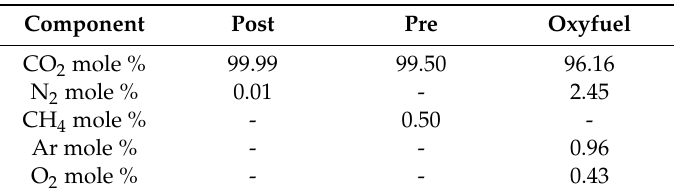
Table 3. CO 2 Mixture